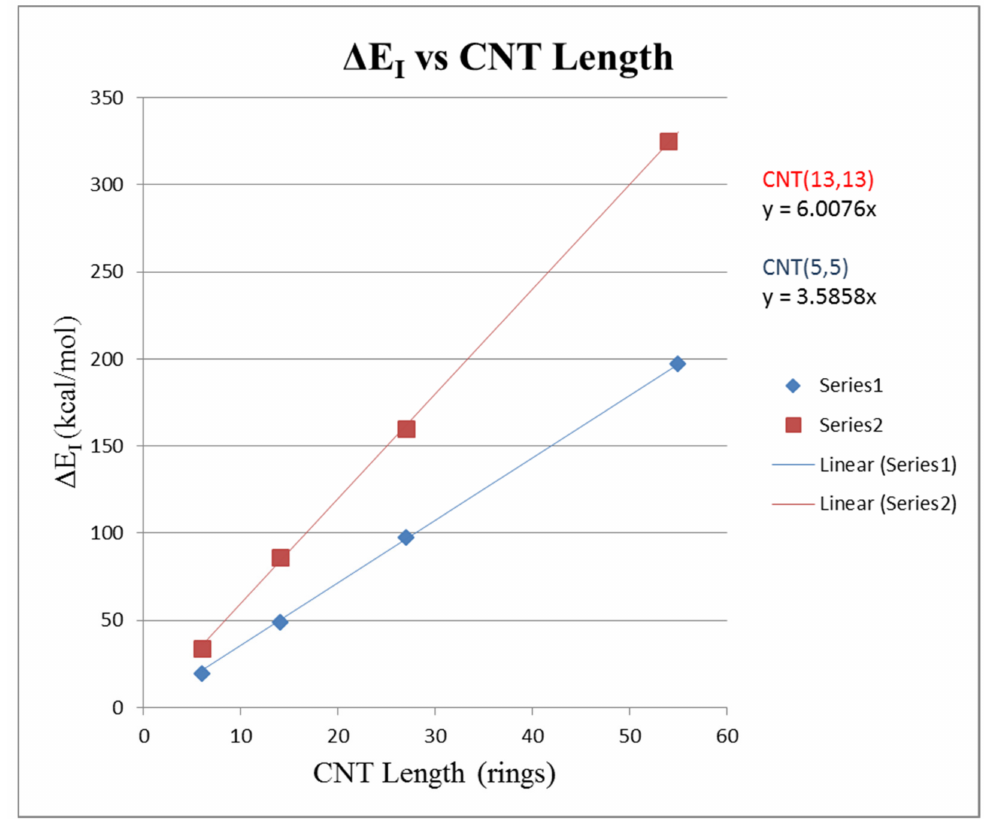
Figure 8. Pairwise binding energy ( ∆ E 1 ) versus the length of CNTs in rings (Z r ); Series 1 blue is from (5,5) CNT pairs with ∆ E 1 = 3.585 Z r ; Series 2 red is (13, 13) CNT pairs with ∆ E 1 = 6.008 Z r